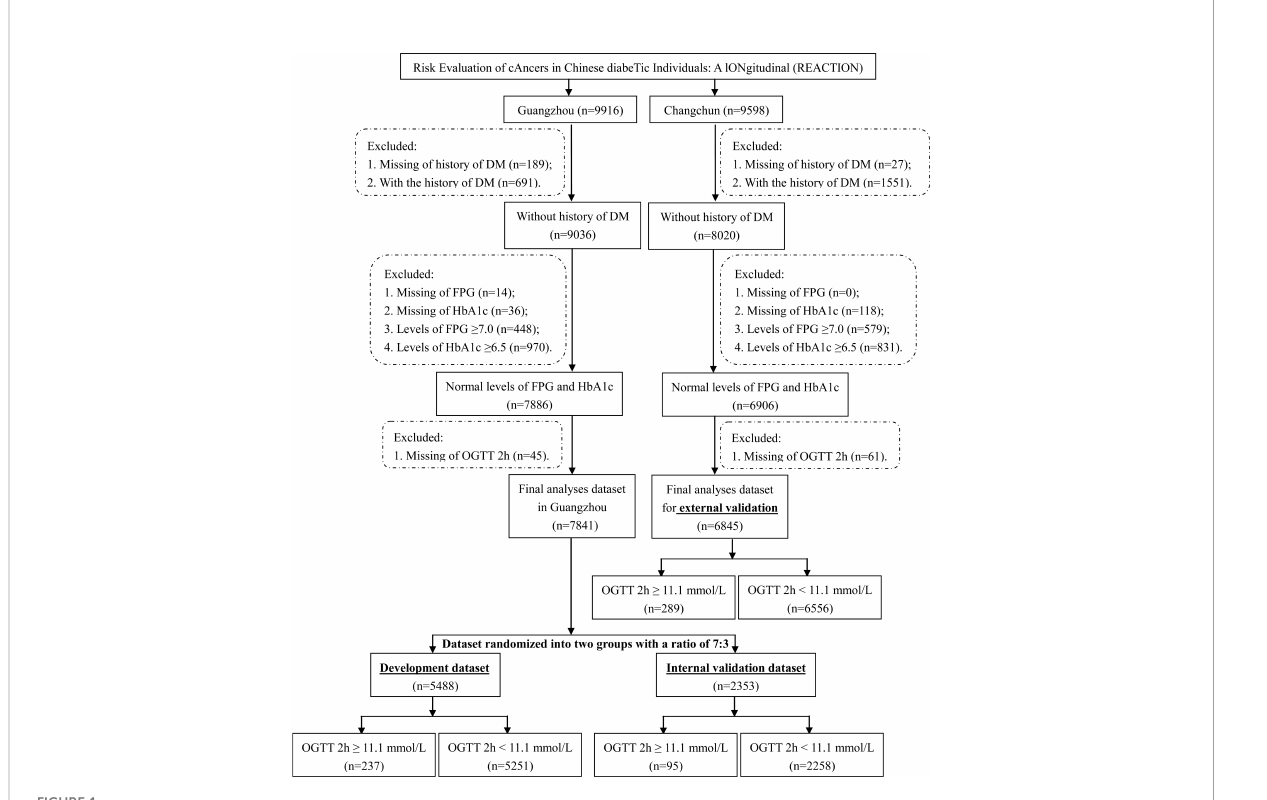
FIGURE 1 Flow chart of the selection of the research